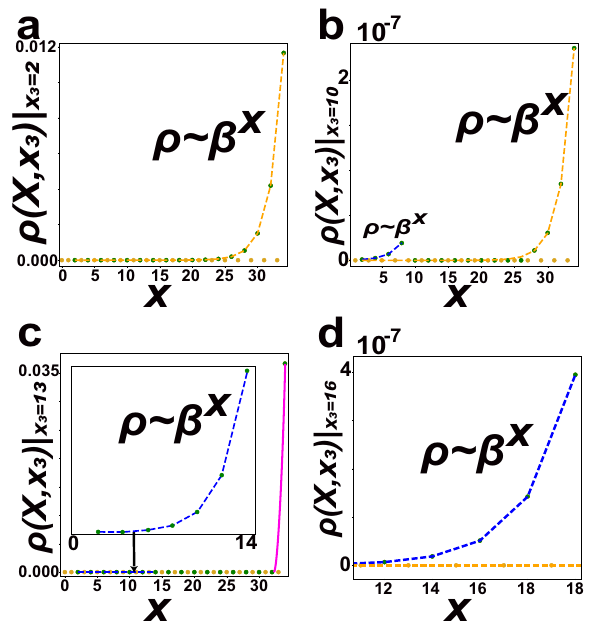
Fig. 7 Details of the skin localization in the effective for the subsection "Cluster states of topological origin" from the section "Method". Exponential localizations in the effective lattice for 3-boson cluster under open boundary conditions (OBCs). 2D cross-sectional density ρ ¼ Ψ ð X ; x ( b ), 13 ( c ), 16 ( d ) of selected states with t 1 = 1.0, t 2 = 0.2, γ = 2.0, L = 20. For the cases x 3 = 2, 10, there is skin localization at the physical boundary(the yellow curves). For the cases x 3 = 10, 13, 16, there is skin localization at the interface (the blue curves). Also present are the trivial mode and the vertex localization (the pink curve in c ) at the intersection between the physical boundary and the interface in the effective lattice. All the blue and yellow curves exhibit the exponential localizations as ρ ~ β x with β = ( t 1 + γ )/( γ − t 2 ).